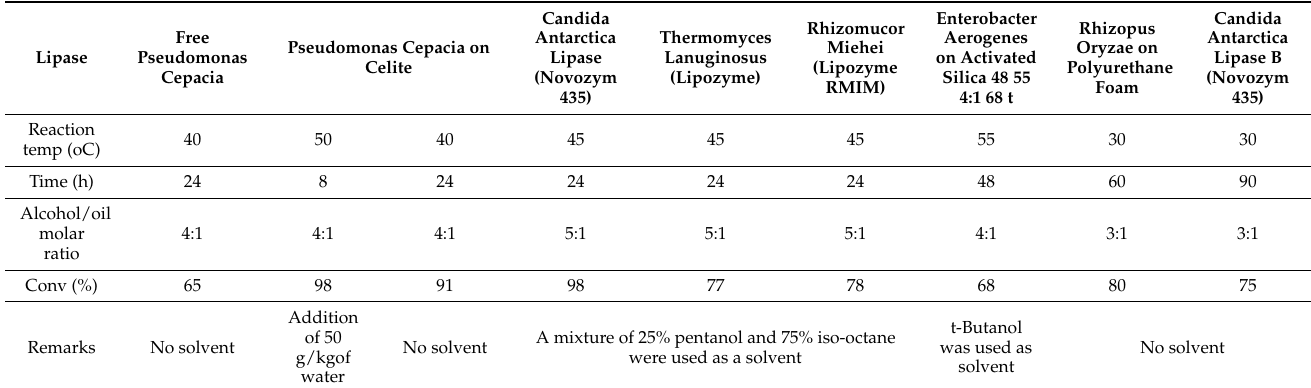
Table 5. Outline of Jatropha curcas oil enzymatic transesterification.